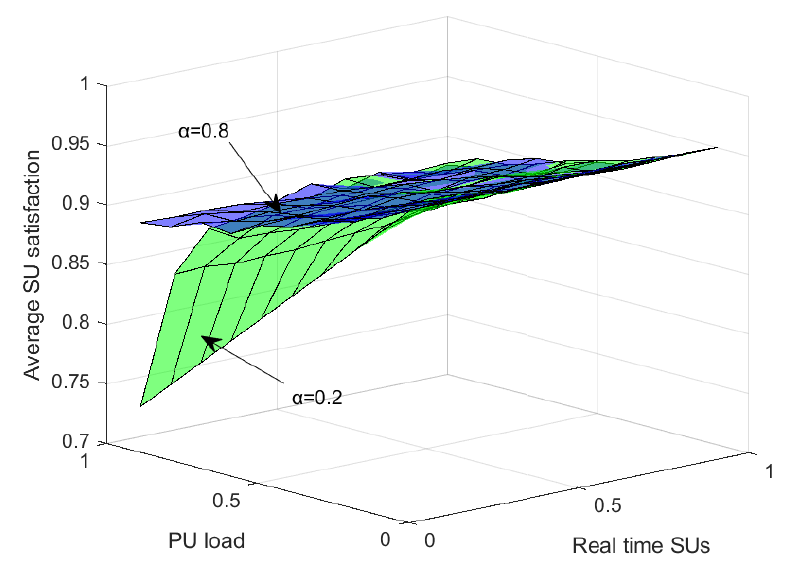
Figure 11. Average SU satisfaction at a different value of α with variation in the PU load and real-time SUs.